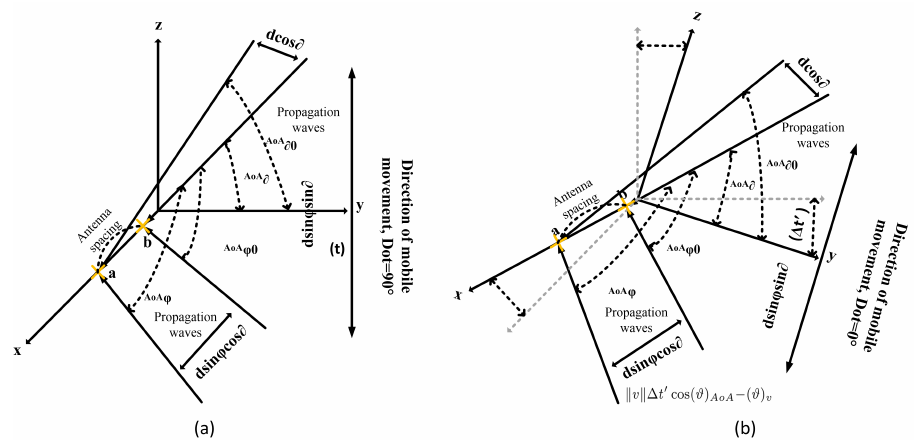
Figure 3. Phase difference between antenna elements for the varying ( a ) DoT = 90 ◦ and ( b ) DoT = 0 ◦